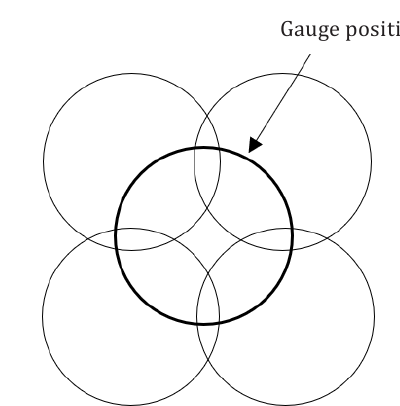
Gauge position 1 of 5